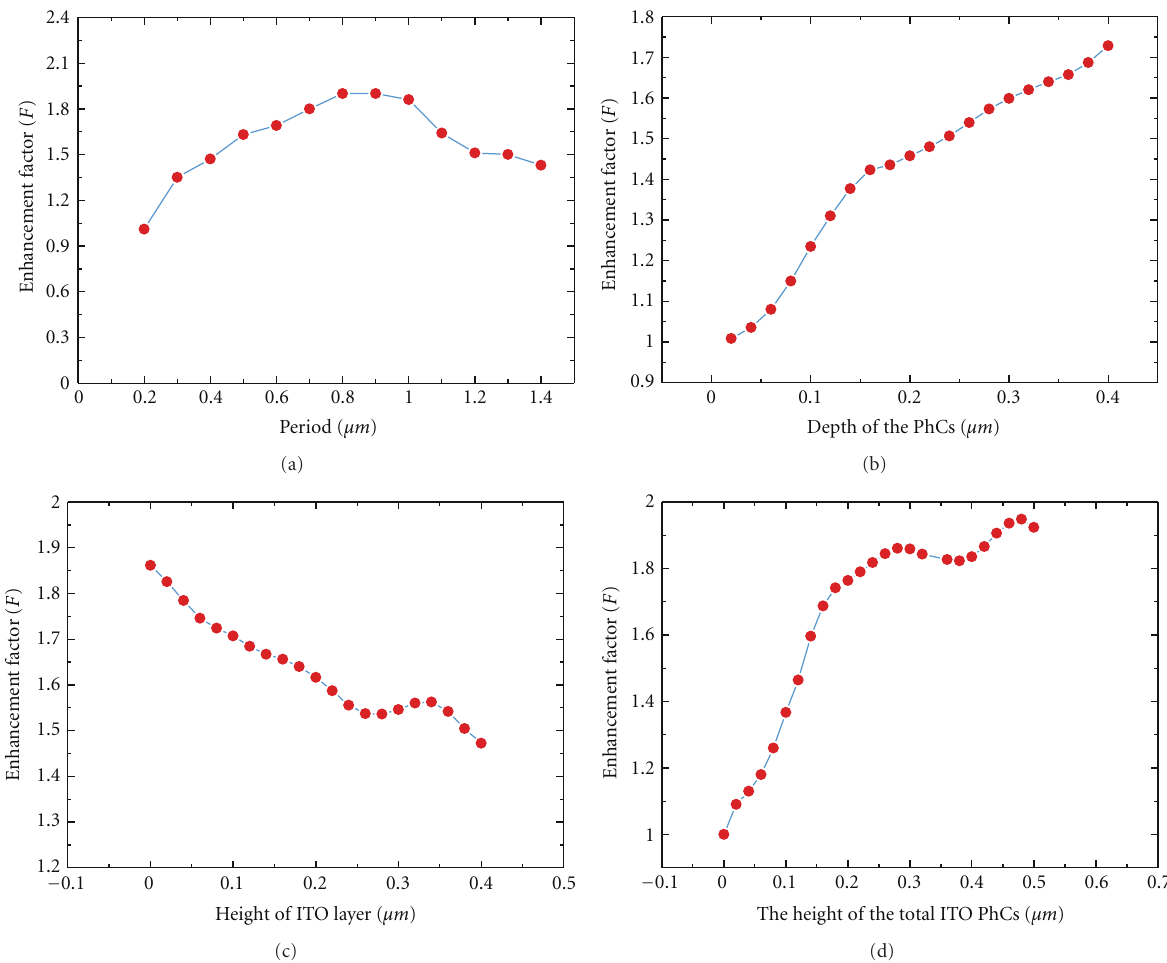
Figure 6: Enhancement of light out-coupling e ffi ciency as a function of (a) period of the PhCs p, (b) depth of PhCs embedded in the SiN x layer d, (c) height of ITO layer h, and (d) height of the total ITO layer H.